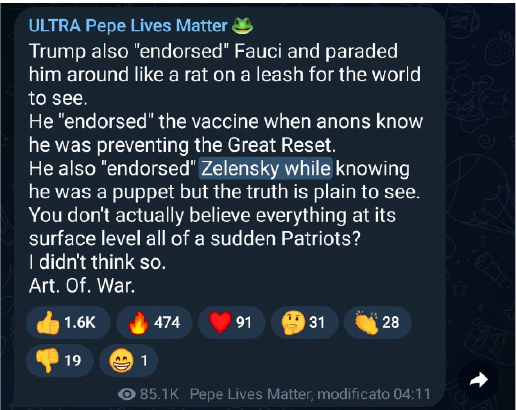
Figure 5. ULTRA Pepe Lives Matter: Double